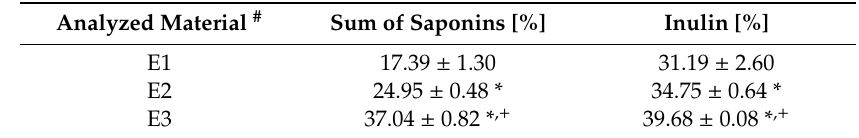
Table 1. Sum of saponins and inulin contents in di ff erent water extracts of Platycodon grandiflorum A. DC ( PG